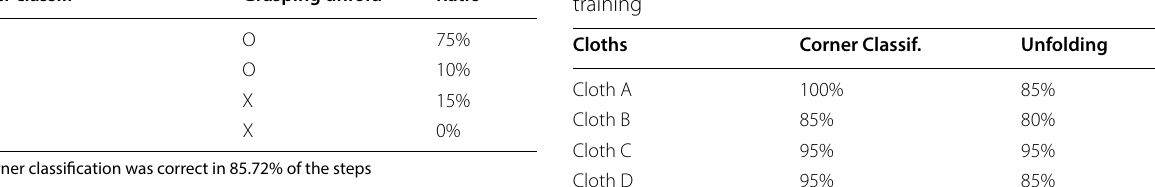
Table 1 Outcomes of 20 grasping attempts Corner classif.